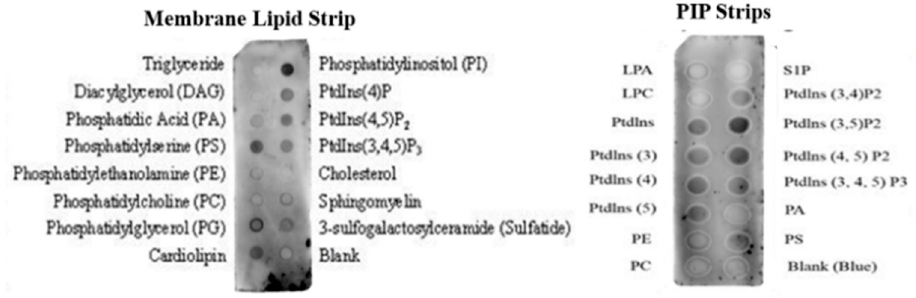
Figure 12. Interaction of P19 with lipids.